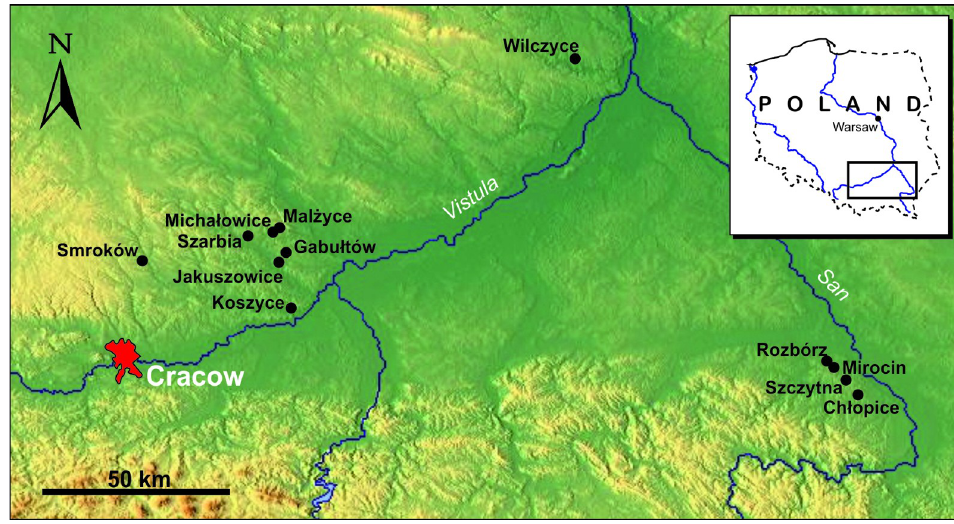
Fig 1. Map of south-eastern Poland with the location of archaeological sites in which the human and animal remains were investigated for the present study. Inset shows the location of the study area in Poland.